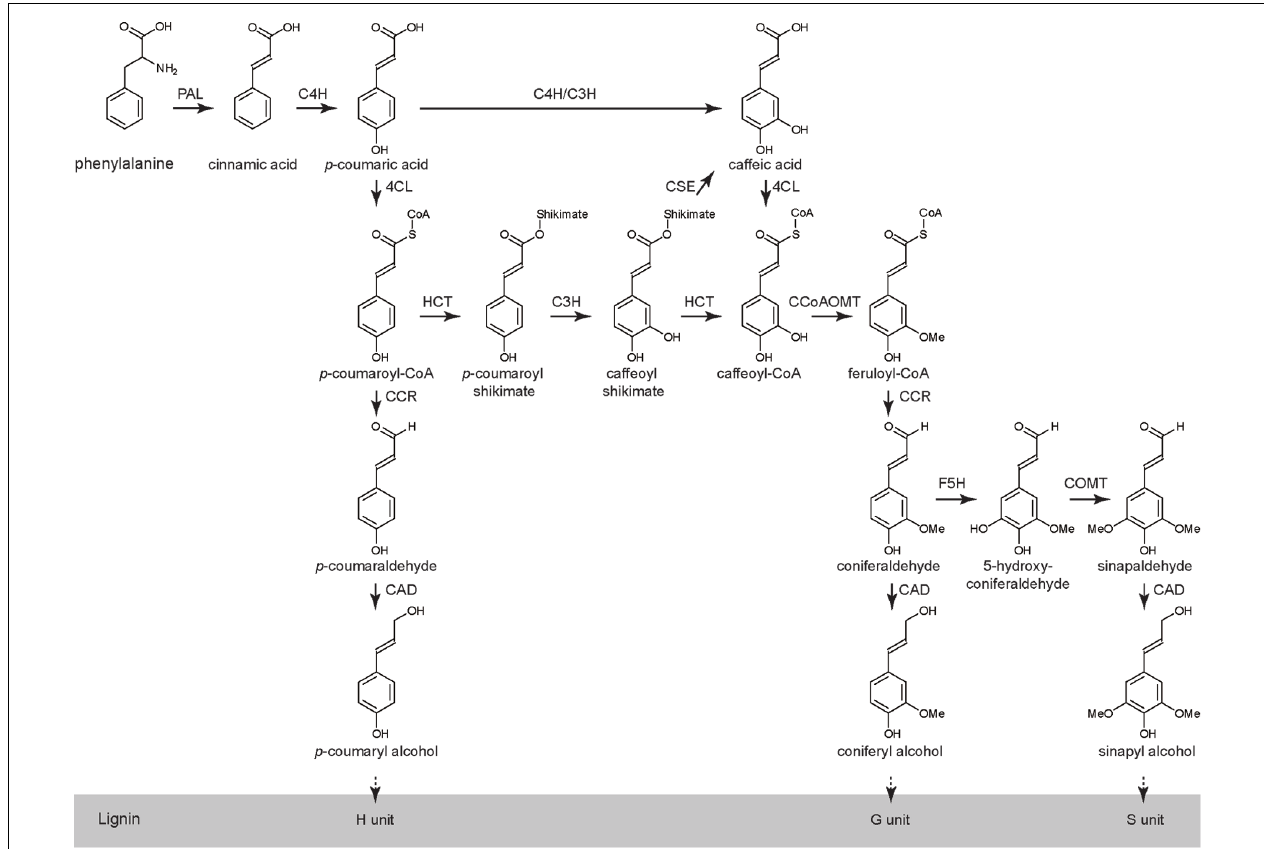
FIGURE 1 |The phenylpropanoid and monolignol biosynthetic pathway in Arabidopsis (adapted fromVanholme etal., 2010,